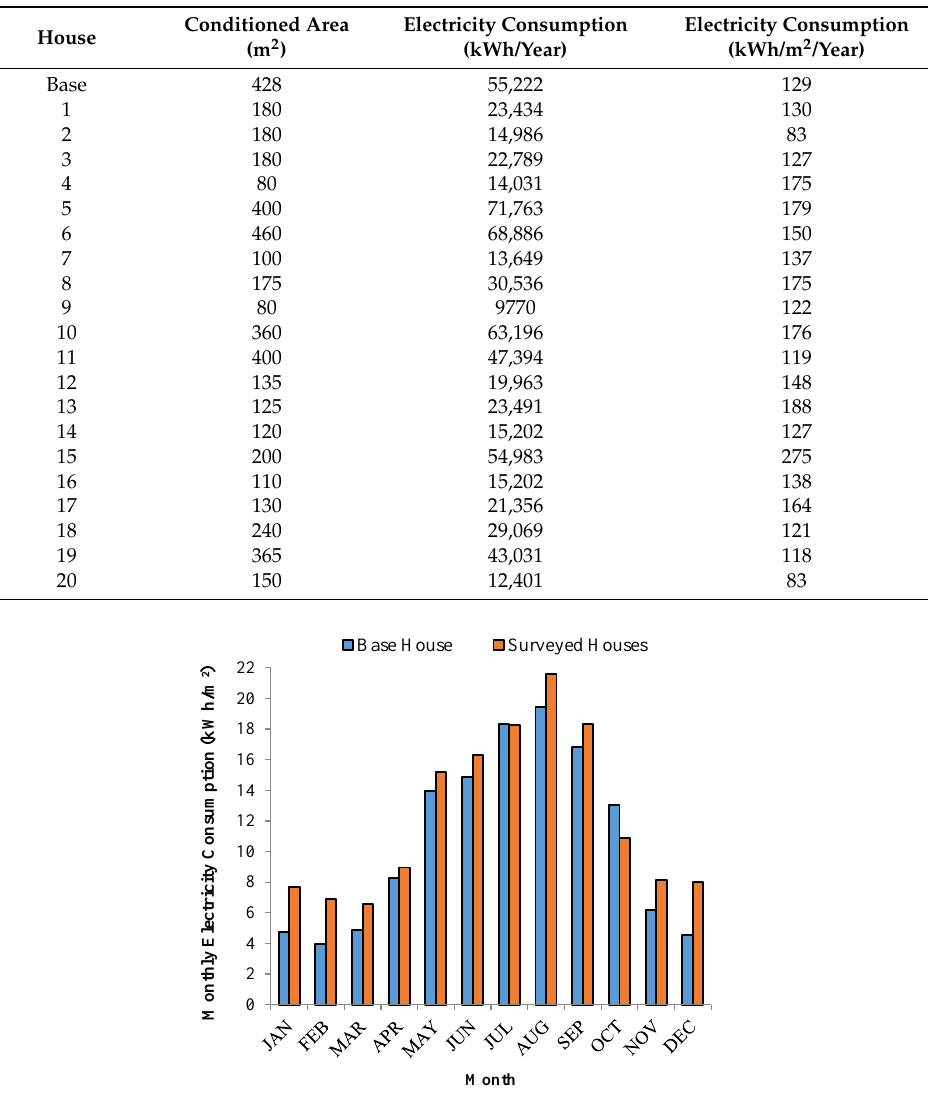
Figure 12. Monthly electricity consumption for the base house and surveyed houses.